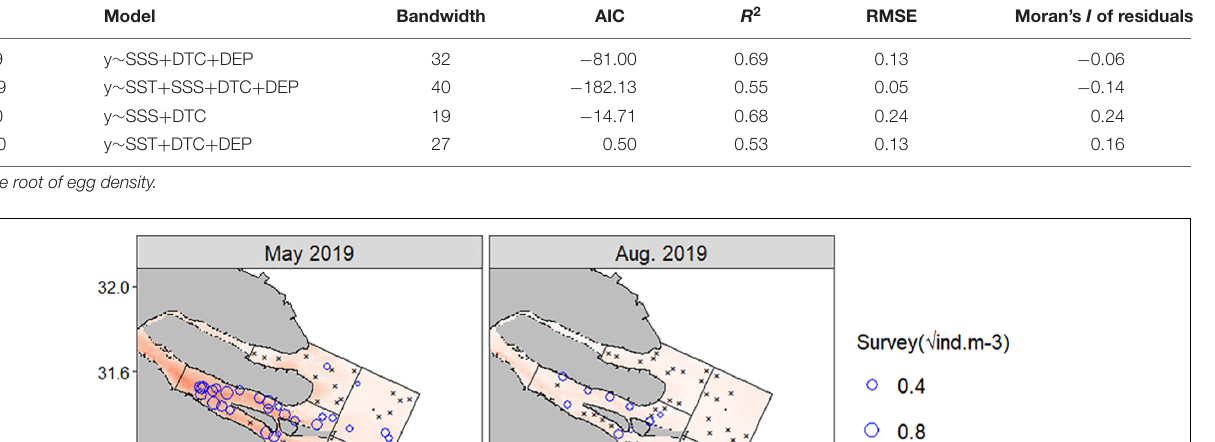
Frontiers in Marine Science |